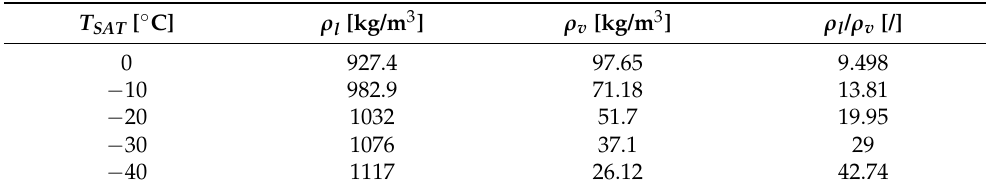
Table 10. Variation in properties (liquid density, vapor density, and density ratio) with respect to different saturation temperatures.